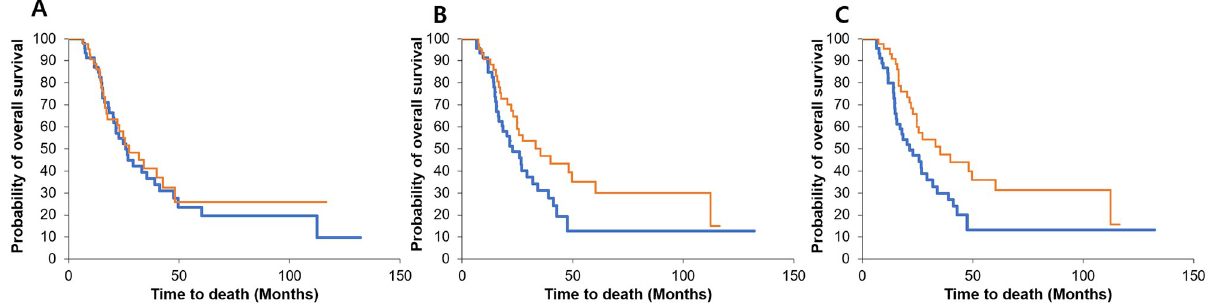
Fig 3. Survival according to the change in the visceral fat mass ratio (VFR). When we analyzed the VFR, the overall survival (OS) did not differ significantly between the higher and lower groups at 4 ( P = 0.732) and 12 ( P = 0.060) weeks after resection (A, B). However, the OS was longer in the higher visceral fat group at 24 weeks (35 vs. 22 months, P = 0.023)